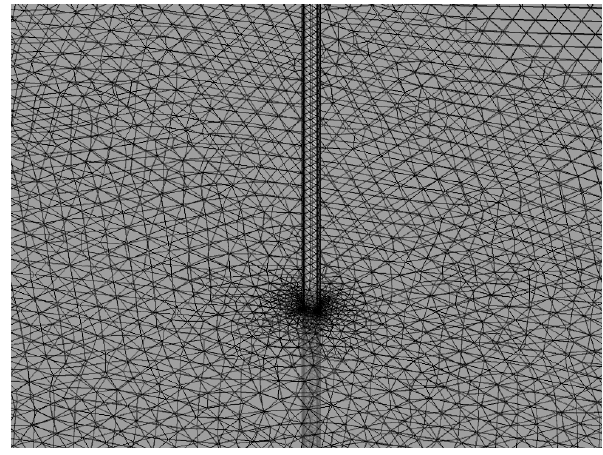
Figure 4. Meshing diagram of the shaft and hydraulic fracture (tetrahedral mesh).